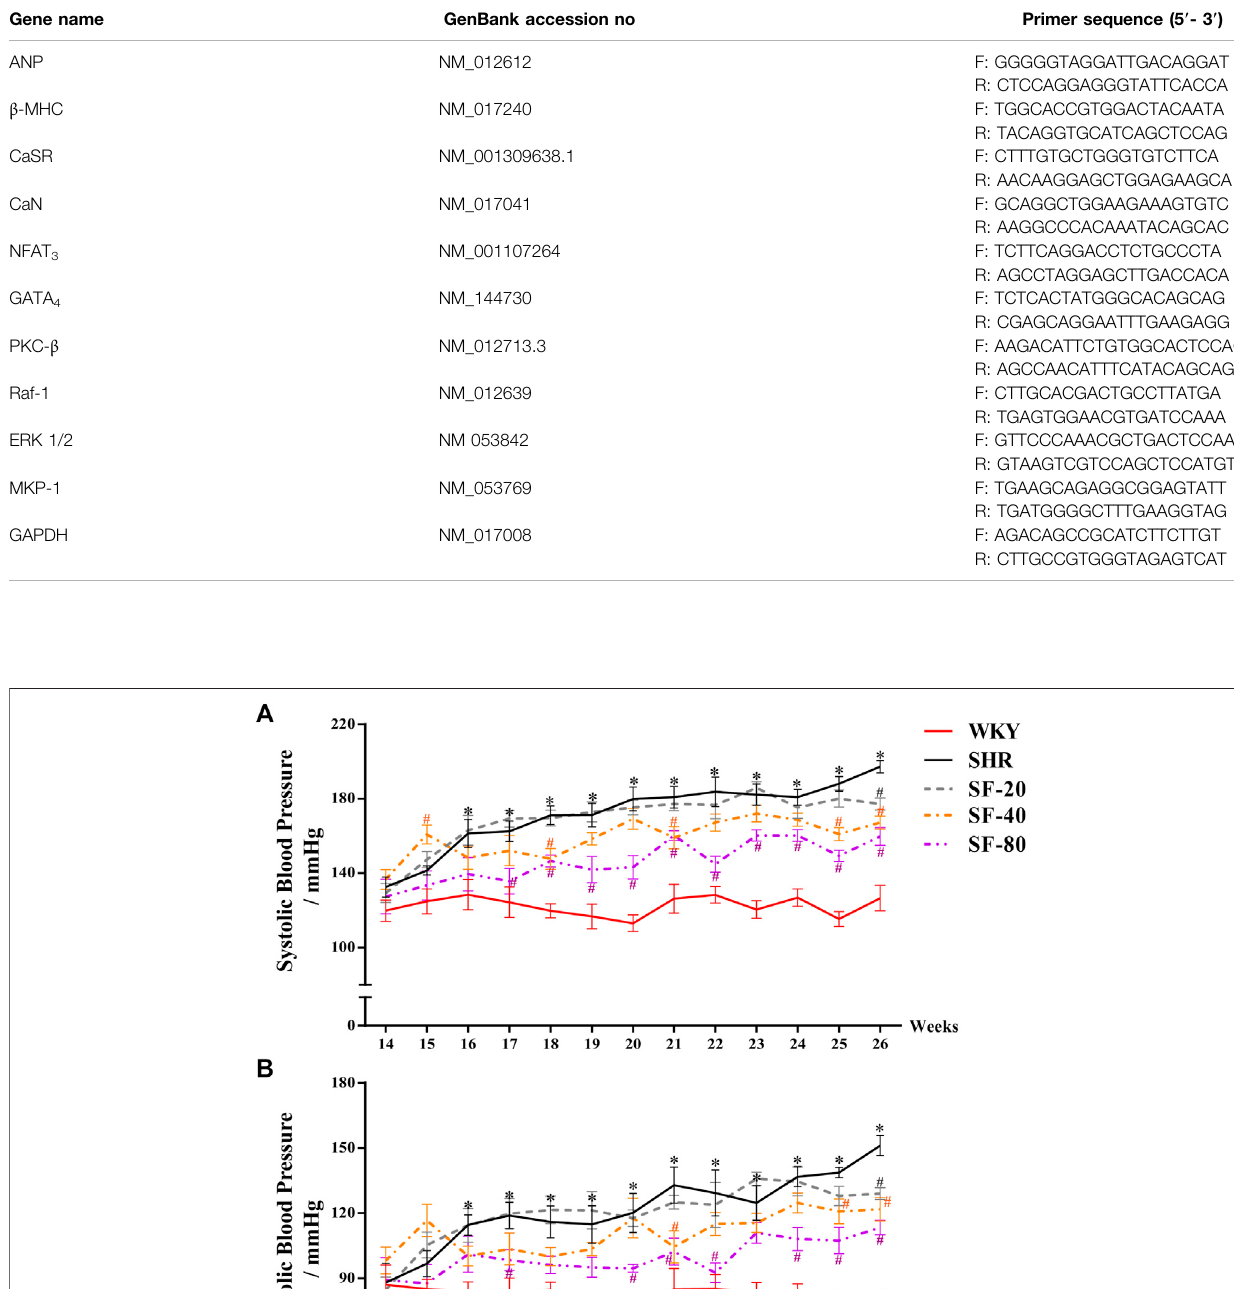
TABLE 1 | Sequences of the primers pairs used for real-time PCR.